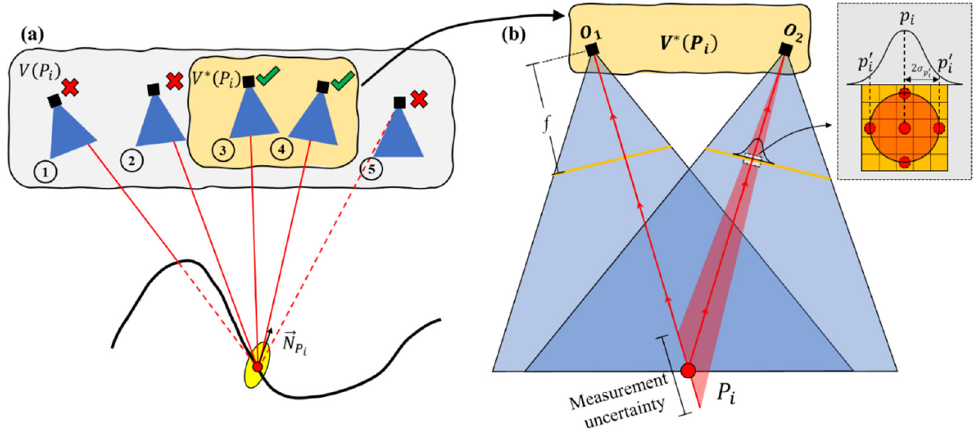
Figure 3. Error space generation. ( a ) Visibility check; ( b ) measurement uncertainty.